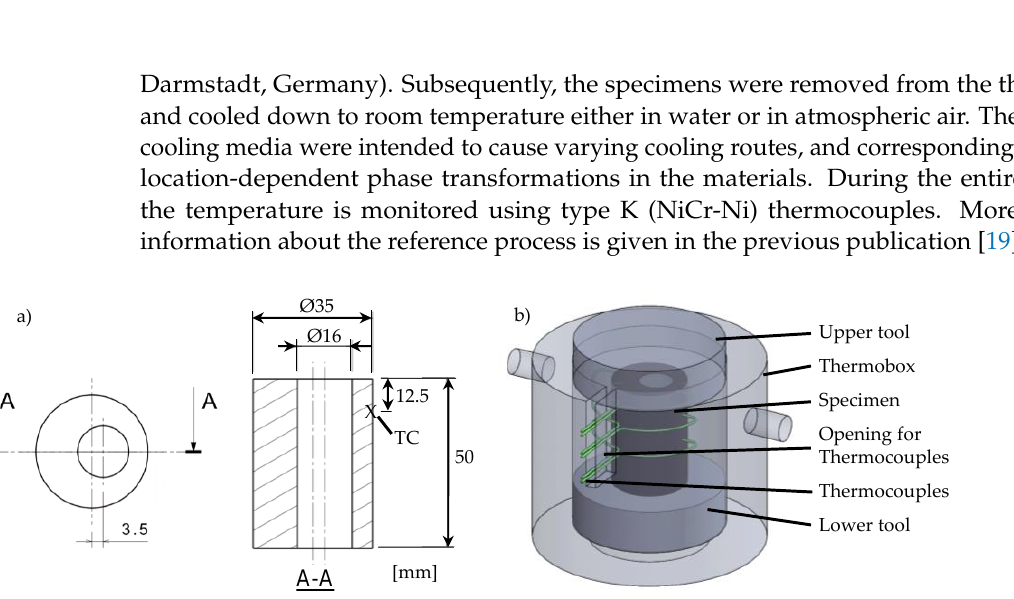
Figure 1. Shape of the specimens investigated with dimensions in mm ( a ), and a schematic representation of the specimen prepared with thermocouples (TC) in a thermobox ( b ) [19].